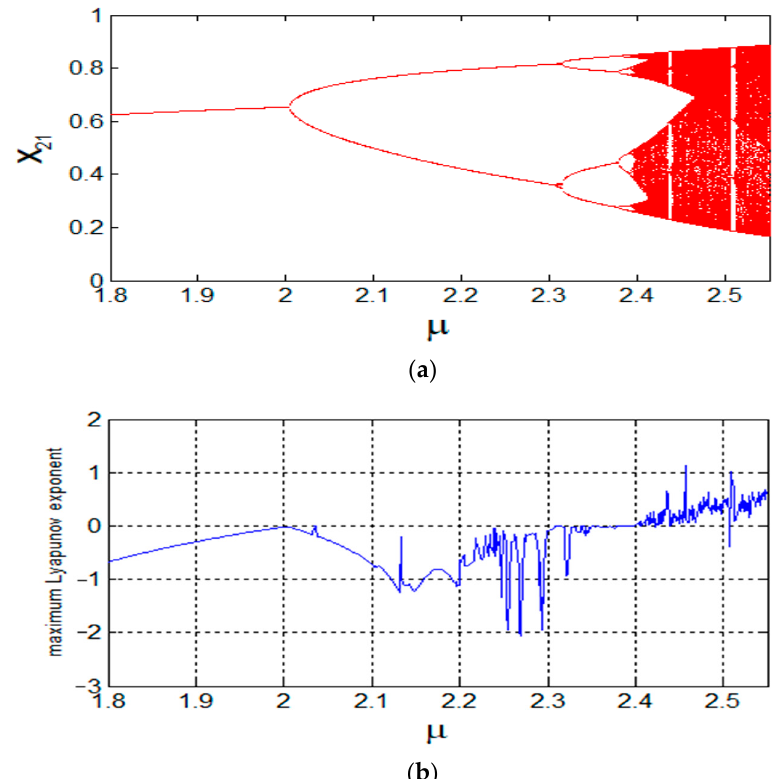
Figure 3. The bifurcation diagram and maximum Lyapunov exponent diagram for μ . ( a ) Bifurcation diagram; ( b ) maximum Lyapunov exponent diagram.